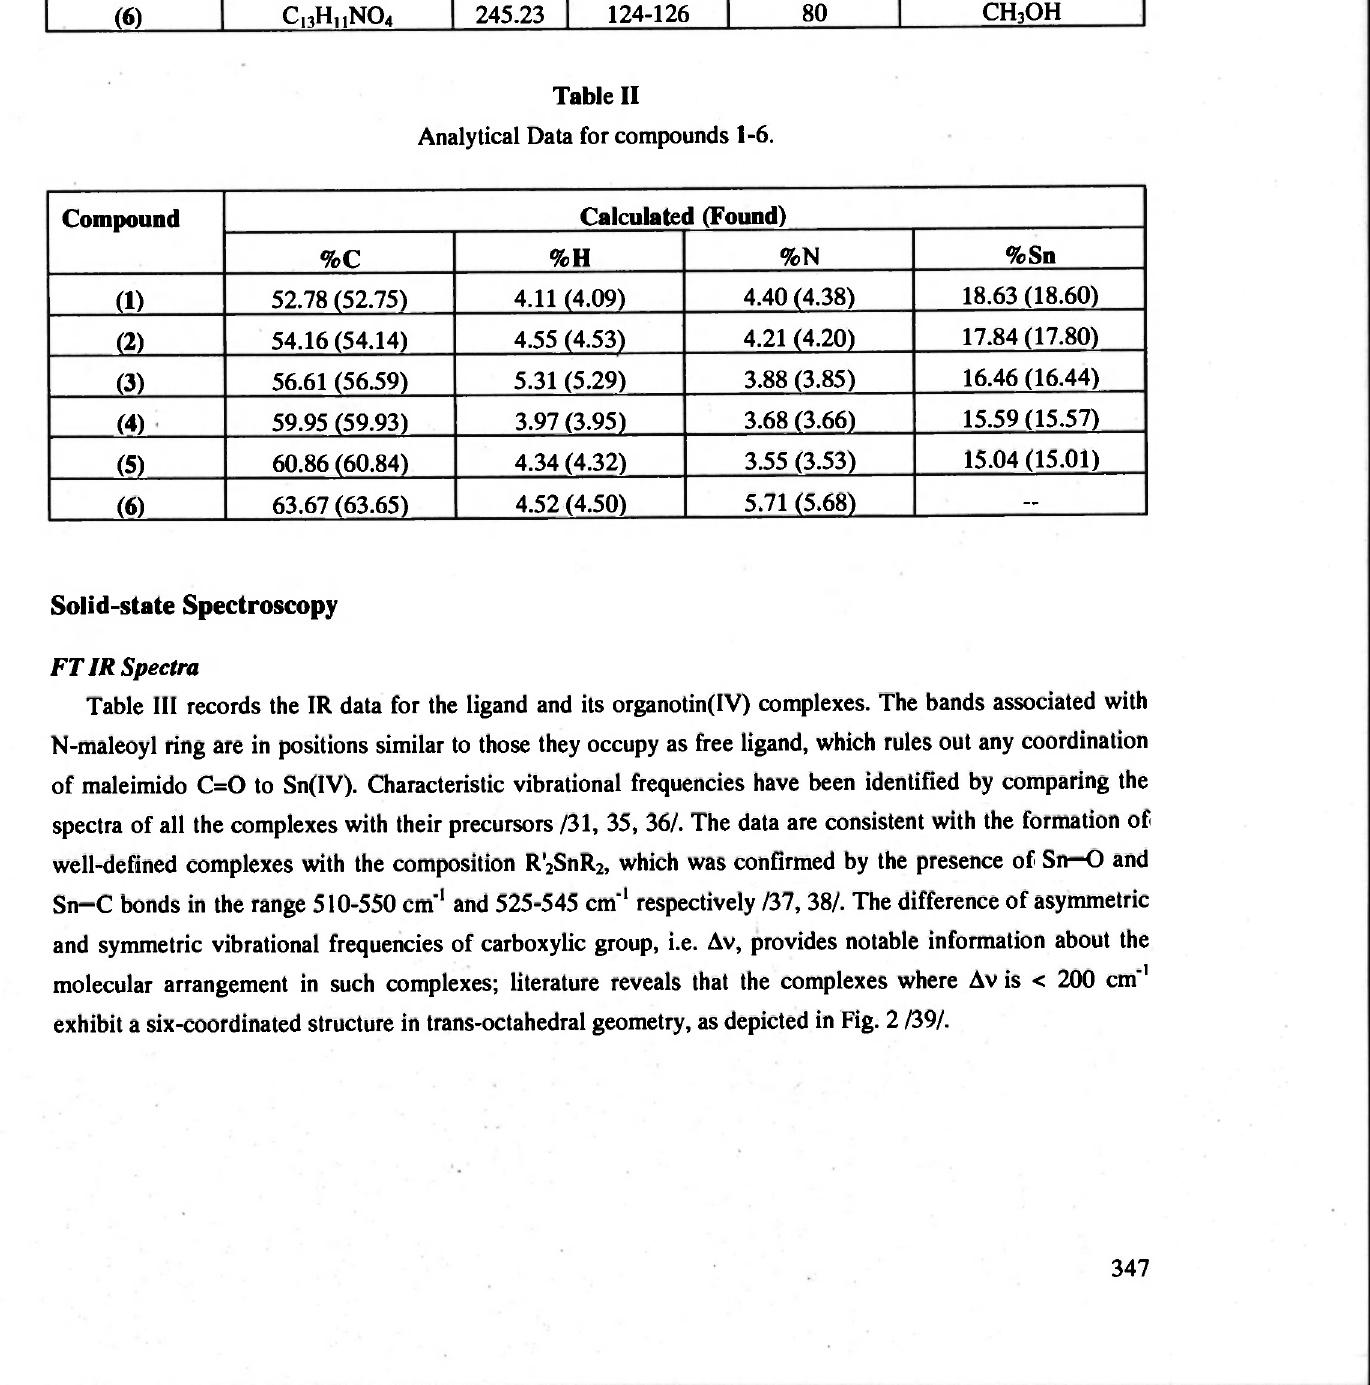
Analytical Data for compounds